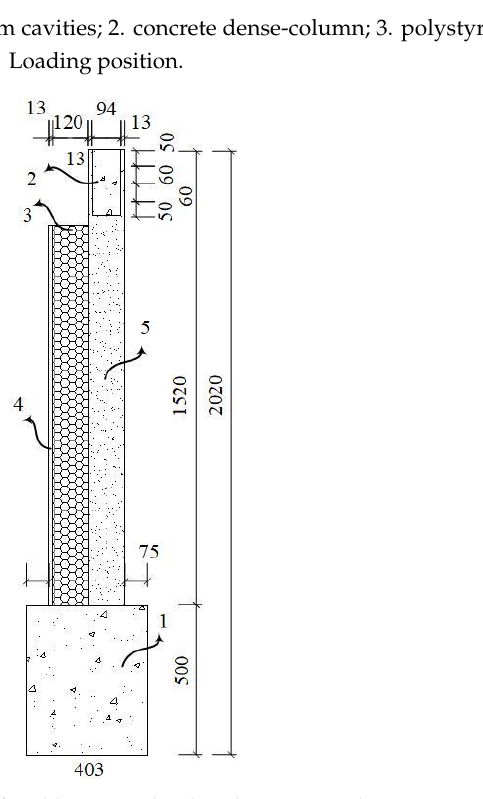
Figure 2. Elevation view. Notes: 1. fixed beam; 2. loading beam; 3. polystyrene insulation board; 4. gypsum protection board; 5. gypsum-concrete dense-column composite board.